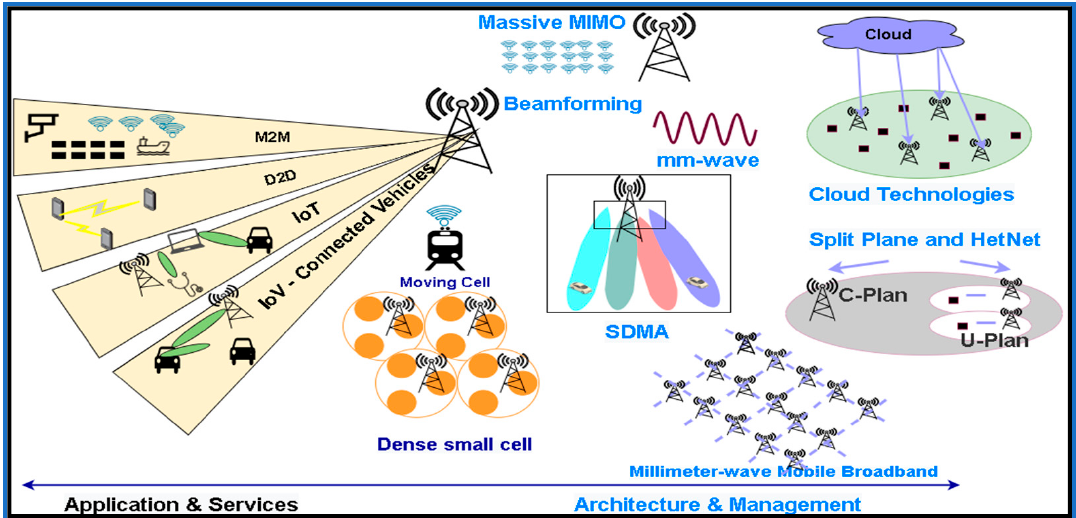
Figure 4. 5G design and applications [35].